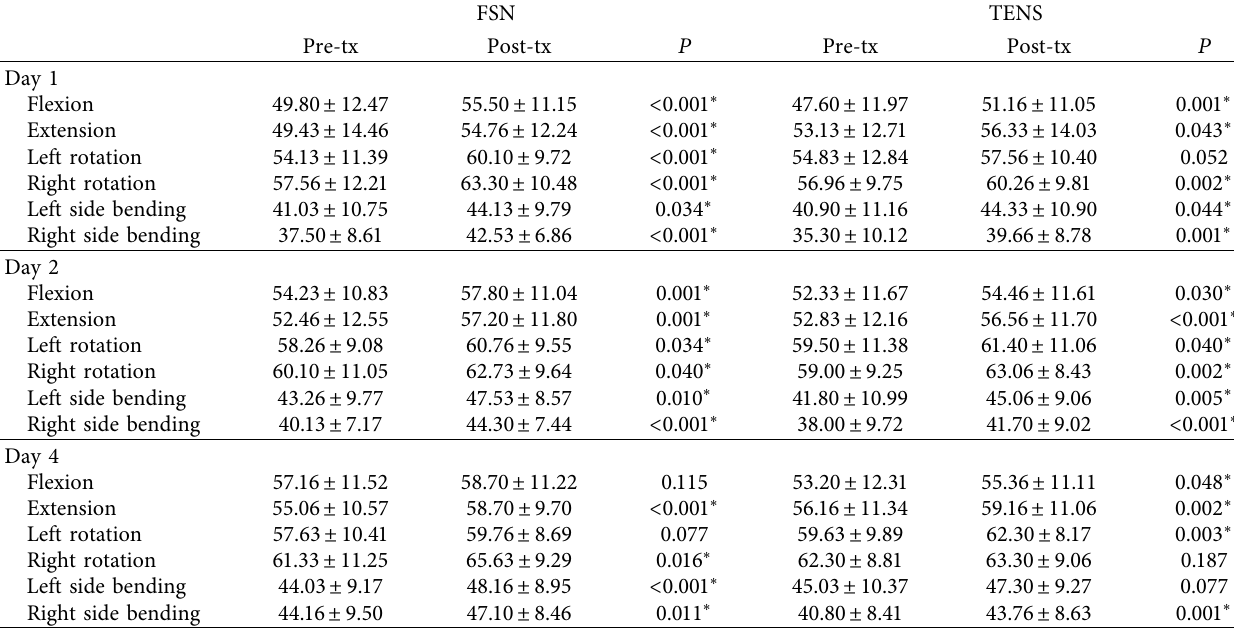
Table 5: Immediate effects of FSN and TENS groups on